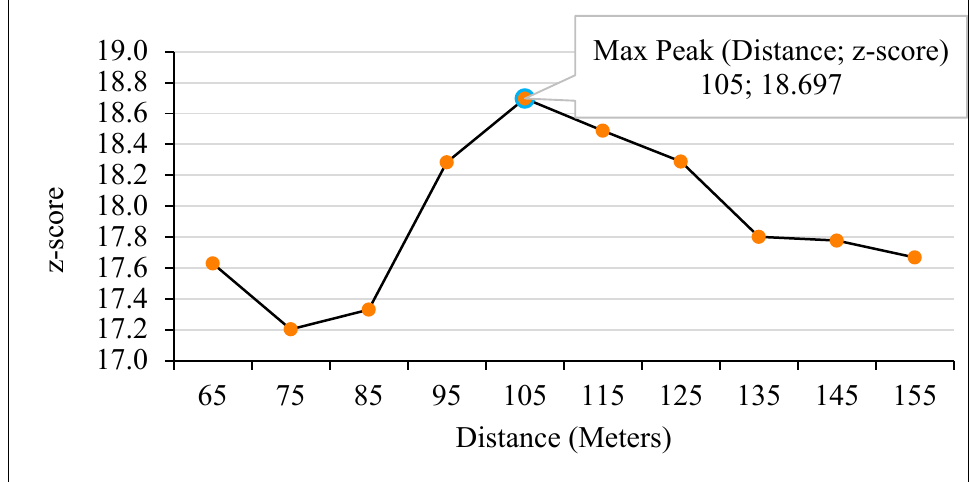
Figure 6. Graphical representation of the incremental spatial autocorrelation by distance and the peak value.